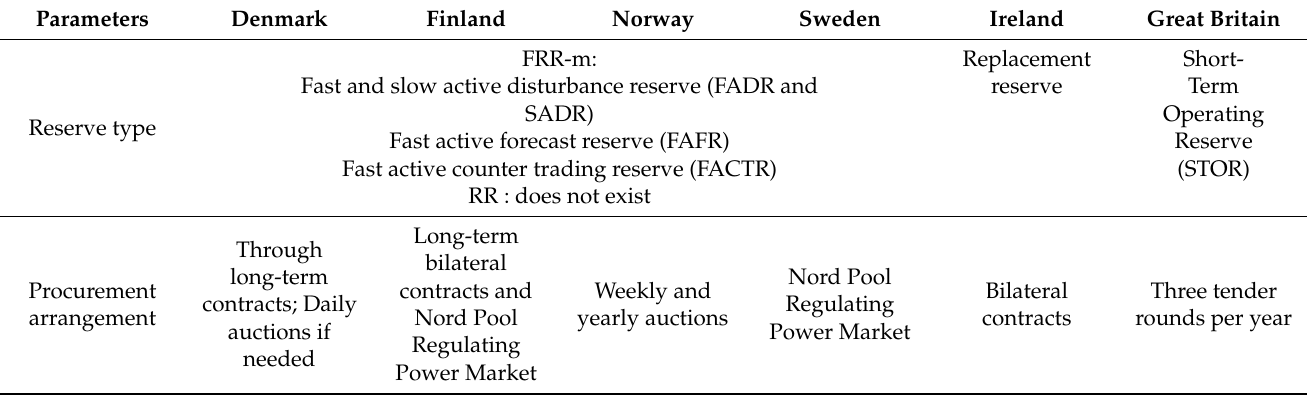
Table 5. Summary of FRR-M and RR services unified under the ENTSO-E classification, including Nordic countries, Ireland and Great